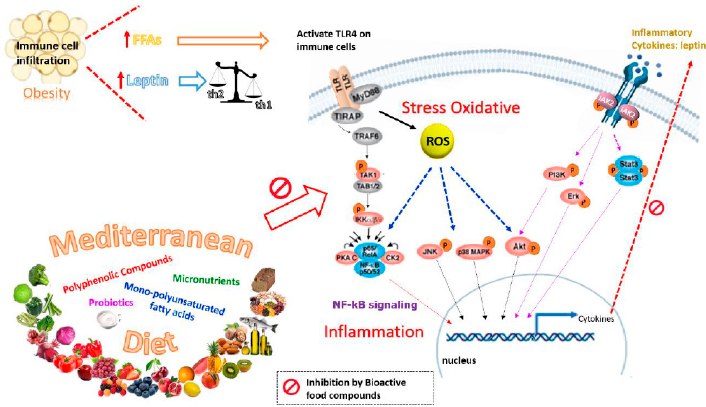
Figure 2. Effects of the Mediterranean diet on the oxidative stress and inflammation associated with obesity and gestational diabetes. Obesity and GDM are linked with higher susceptibility to oxidative stress and inflammation. Adipocyte hypertrophy results in elevated circulation of free fatty acids (FFAs) and increased secretion of leptin, which drives T cells toward a pro-inflammatory phenotype (Th1). These in turn result in immune cell infiltration and the activation of pro-inflammatory signaling pathways. Bioactive food compounds in the Mediterranean diet such as polyphenols exert their